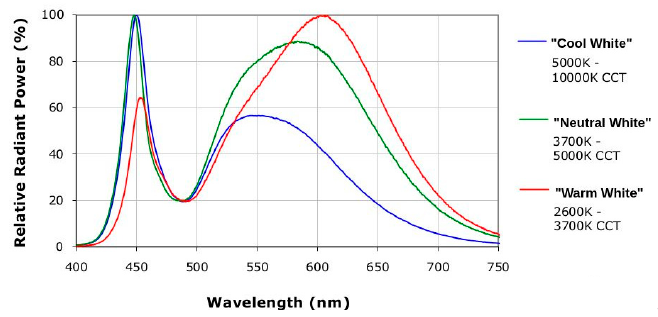
Figure 2. An example spectrum of most of the white color light-emitting diodes (LEDs).